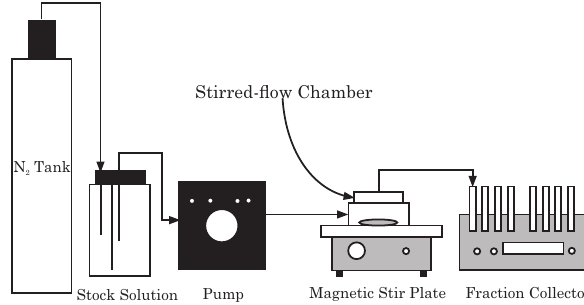
Figure 1. Stirred-flow system (Strawn & Sparks,